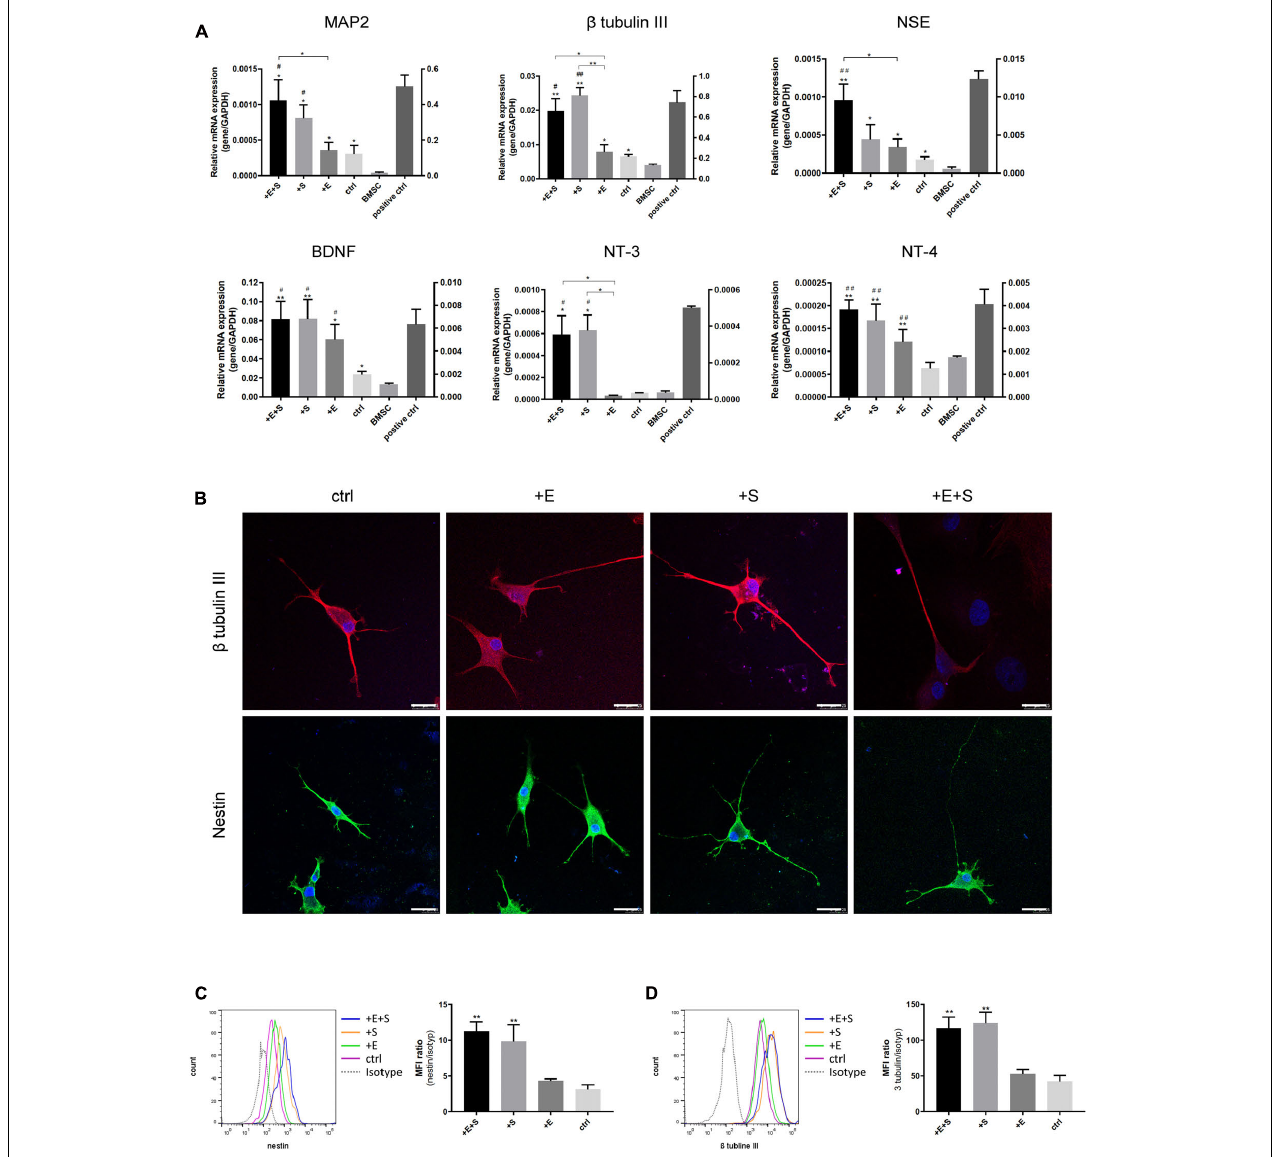
FIGURE 4 | Effects of the strain and electrical stimulation on the neural related gene expressions of BMSCs. (A) BMSCs were induced by the neural differentiated medium under static conditions (ctrl) or under cyclic strain (+S, 5% elongation, 0.5 Hz), under electrical stimulation (+E, 1 V/cm, 0.5 Hz), and under co-stimulation (+ E + S) for 24 h. Gene expression of MAP2, β -tubulin III, NSE, BDNF, NT-3, and NT-4 on day 13 was analyzed by real-time RT-PCR and normalized to GAPDH. Normal neonatal rat neurons were used as positive control. Results are shown as mean ± SD ( N = 4). * p < 0.05, ** p < 0.01 compared to the BMSC, # p < 0.05, ## p < 0.01 compared to the static control. (B) Representative immunostaining images of neural differentiated BMSCs under treatments. Immunocytochemistry detecting β tubulin III (red) and nestin (green) expressions in BMSCs with DAPI (blue) under different treatments (scale bar = 25 µ m). Representative flow cytometry histograms showing the protein expression of β tubulin III ( C left) and nestin ( D left) and statistical analysis of β tubulin III ( C right) and nestin ( D right) expression level under treatments ( n = 3, ** p <